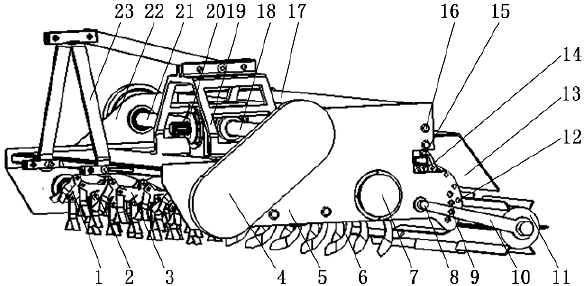
Figure 8. Simpli fi ed schematic of green manure sha tt ering − rotary tillage integrated machine be- Figure 8. Simplified schematic of green manure shattering-rotary tillage integrated machine between